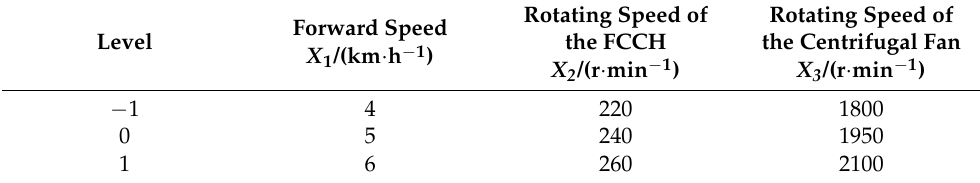
Table 1. Test factors and